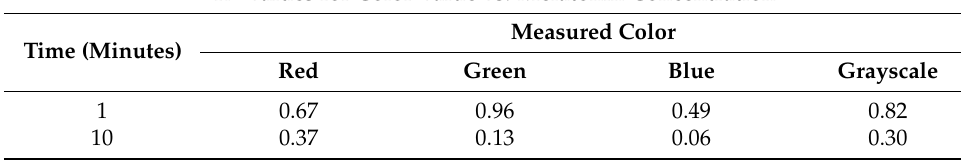
Table A1 includes the linear regression data for mean color values versus melatonin concentration. Table A1. R 2 Values for the linear regression models for mean color values based on the melatonin concentrations. Sorted by the measured color and the time at which the measurements were taken following the addition of the Congo Red Dye. Values calculated using Excel. R 2 Values for Color Value vs. Melatonin